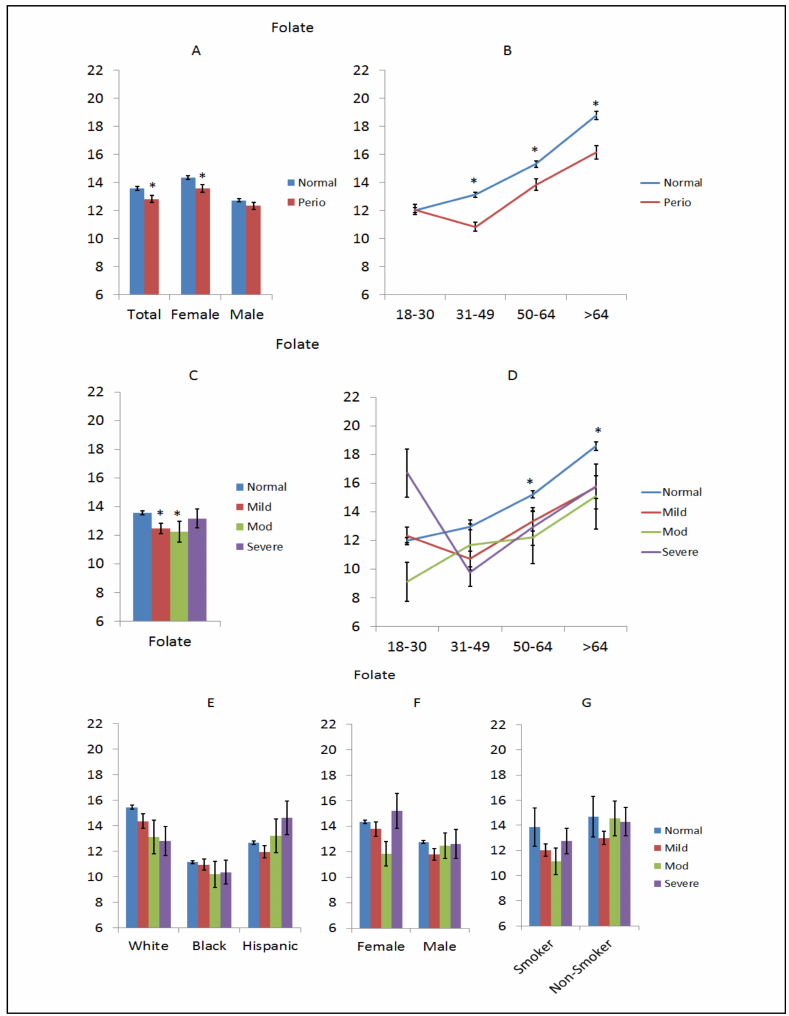
Figure 3. Levels of folate (g/mL) in subjects with or without periodontitis stratified upon sex ( A ), age ( B ), disease severity ( C ), disease severity and age ( D ), race/ethnicity ( E ), disease severity and sex ( F ), and disease severity in smokers ( G ). The bars denote group means and the vertical brackets enclose 1 SEM. The asterisk (*) denotes significantly different than the normal group at p <